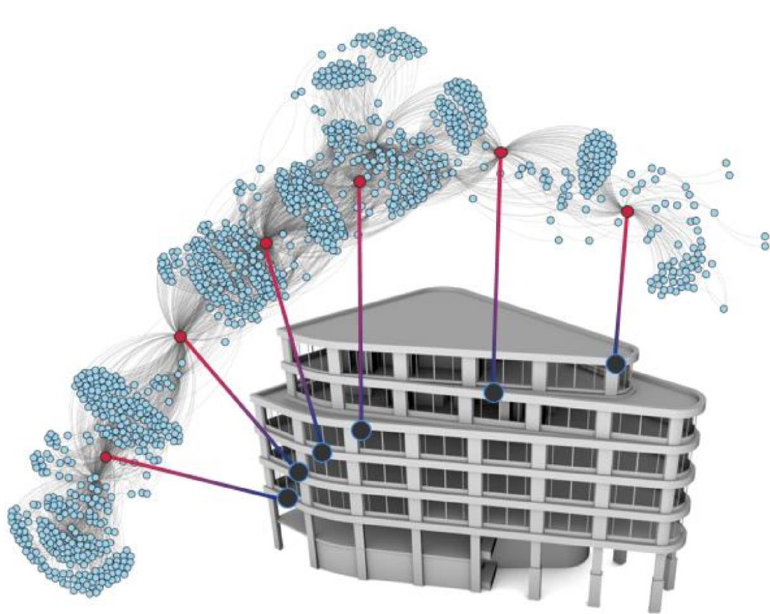
Figure 13. Precedence relationship graph [25].